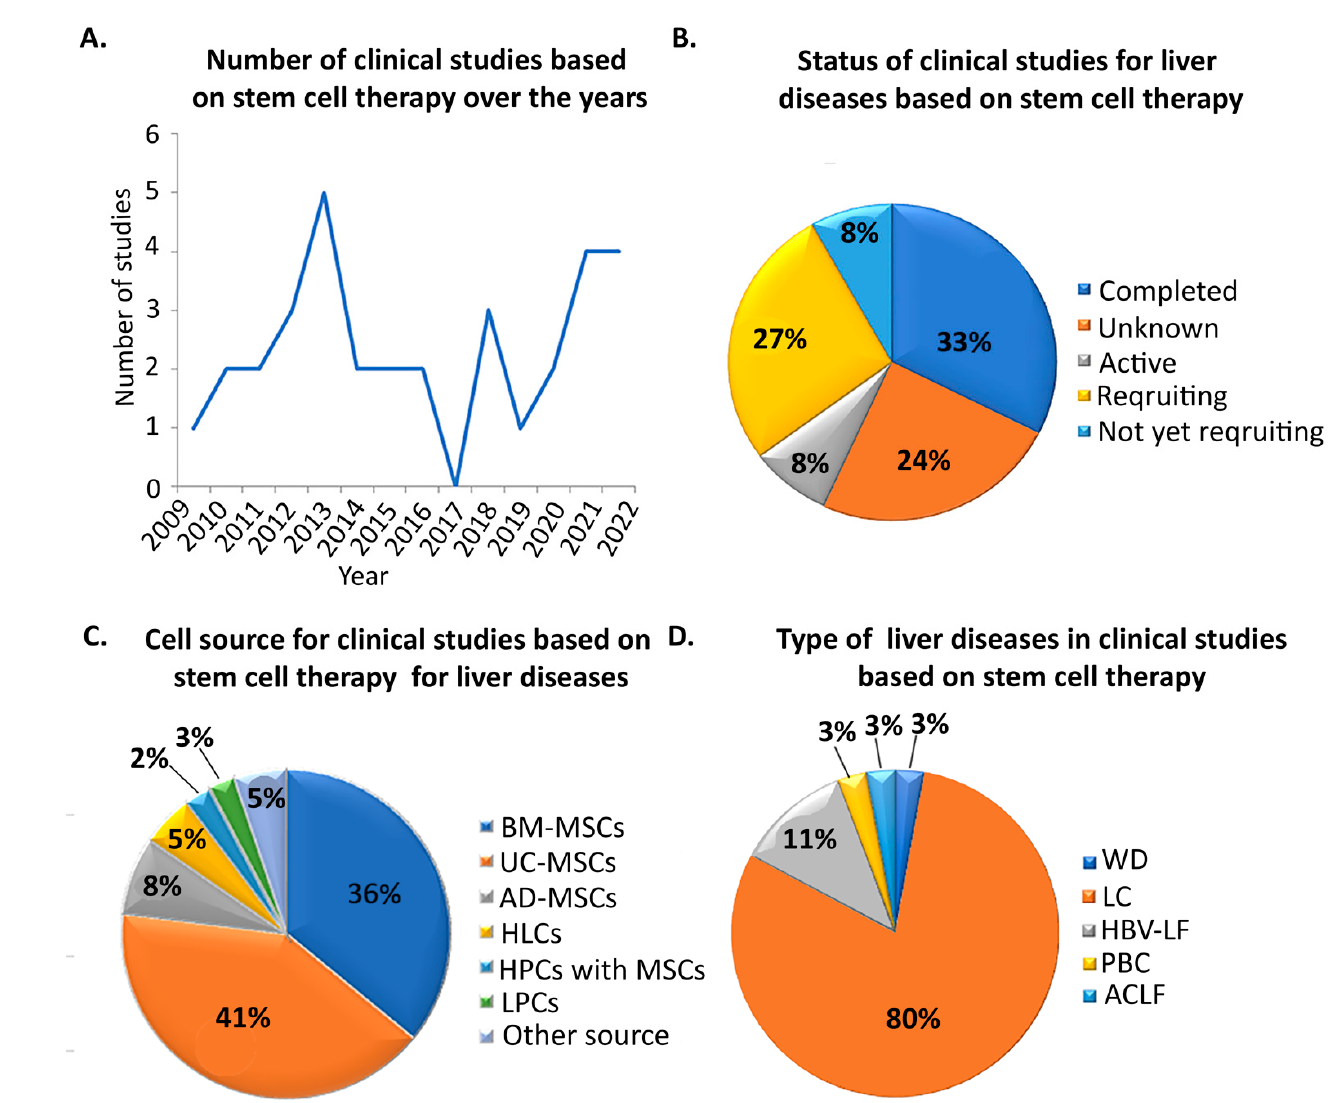
Figure 2. Summary of the clinical trials using MSCs, HLCs or LPCs for therapy of liver diseases. ( A ). The graph depicts the number of stem-cell-based studies that have been conducted over the years. ( B ). Pie chart that represents the current status of clinical studies for liver diseases based on stem cell therapy. ( C ). Pie chart that depicts the percentages of the different stem cell sources that have been used in clinical liver therapy. ( D ). Pie chart that represents the percentages of clinical studies for liver diseases based on stem cell therapies. BM-MSCs: Bone Marrow MSCs; UC-MSCs: Umbilical cord MSCs; AD-MSCs: Adipose Tissue MSCs; HLCs: Hepatocyte-Like Cells; HPCs: Hematopoietic Progenitor Cells; LPCs: human Liver Progenitor Cells; WD: Wilson’s Disease; LC: Liver Cirrhosis; LF: Liver Failure; PBC: Primary Biliary Cirrhosis; ACLF: Acute-on-Chronic Liver Failure.